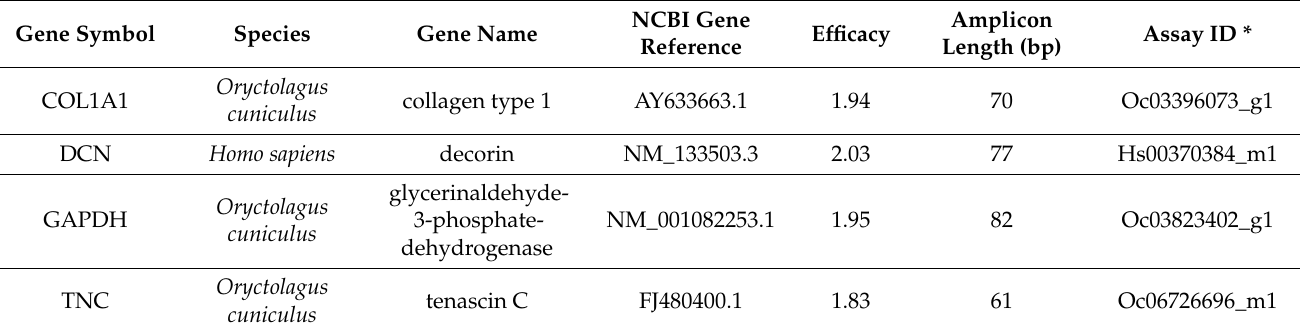
Table 2. Primers used to assess gene expression.